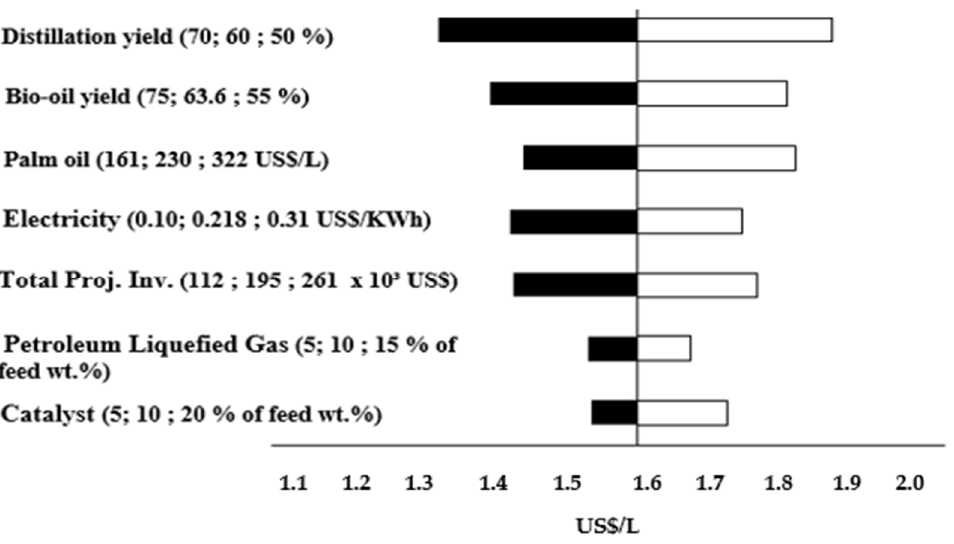
Figure 3. Sensitivity analysis for 900 L/day to reach the baseline transportation fuel MFSP of 1.59 USD/L, the 10% facility of IRR is assumed.